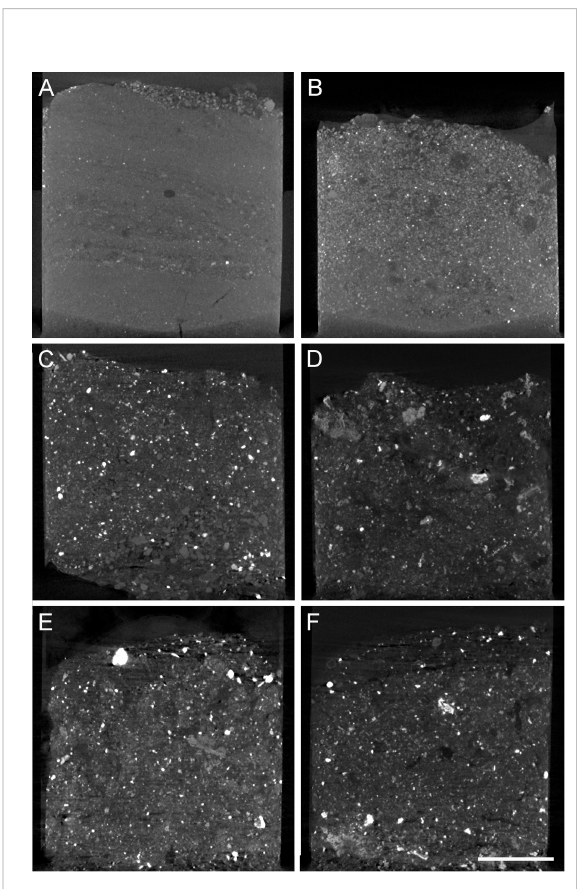
FIGURE 2 Representative vertical cross-section micro-CT scans of FLEC cores from the three habitats. (A) Core 2 from outside the caldera. (B) Core 14 from inside the caldera but away from the chimneys. (C) Core 7 from base of Daimyojin Chimney. (D) Core 19 from base of smaller chimney. (E) Core 8 from base of Daimyojin Chimney. (F) Core 11 from base of the smaller chimney. Scale = 5 mm.